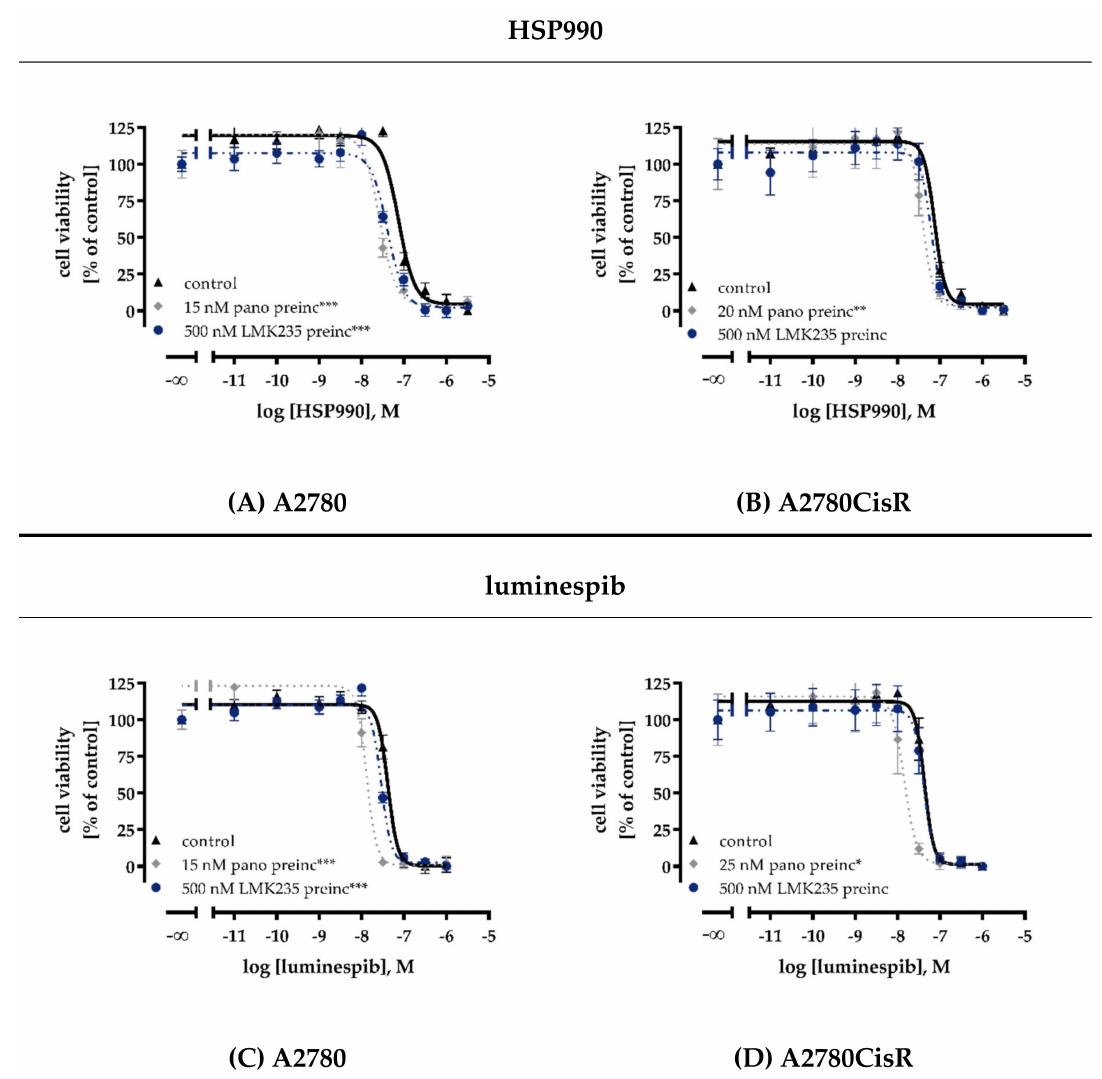
Figure 2. Preincubation with HDACi increase cytotoxic potency of HSP90i. A 48 h preincubation (preinc) with panobinostat or LMK235 with the indicated concentrations decreased IC 50 values of HSP990 ( A , B ) and luminespib ( C , D ) in A2780 ( A , C ) and A2780CisR cells ( B , D ). IC 50 values, pIC 50 and SEM are shown in Table S1. Data shown are mean ± SEM of three independent experiments each carried out in triplicate. Statistical analysis was performed using t-test. Levels of significance: * p ≤ 0.05, ** p ≤ 0.01, *** p ≤